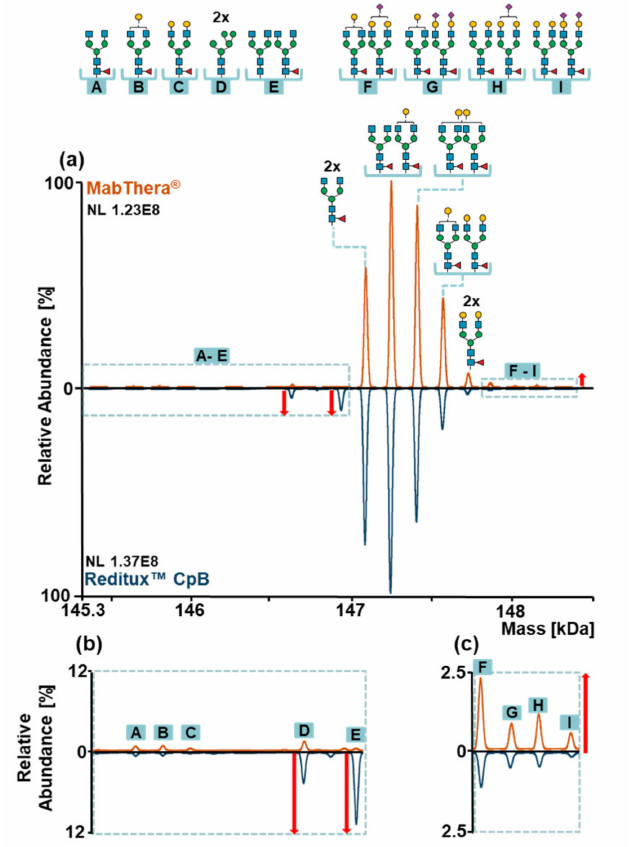
Figure 4. ( a ) Mirror plot of the deconvoluted mass spectra of MabThera ® (orange) and Reditux™ (blue) after carboxypeptidase B treatment (CpB). Glycan structures of main glycoforms are reported above the peaks, while minor glycoforms are indicated with the letters A–I. Differences in relative abundances of glycoforms can be observed between MabThera ® and Reditux™. ( b ) Magnification of minor glycoforms A–E. Red arrows indicate an increased amount of oligomannose (D) and afucosylated (E) glycoforms in Reditux™ compared to MabThera ® . ( c ) Magnification of minor glycoforms F–I. The red arrow indicates an increased amount of sialylated glycoforms (F–I) in MabThera ® compared to Reditux™. Annotations of the spectra are reported in Tables S2 and S5. Glycan structures, names, and compositions are collected in Table